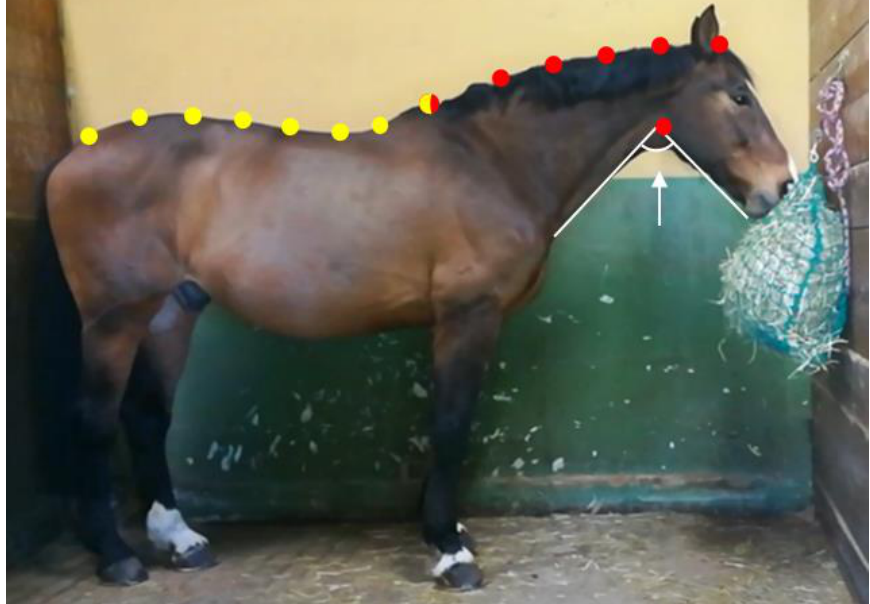
Figure 6. Geometric morphometrics analysis was applied according to the methods described by Tocco et al. [29] and Palestrini et al. [30] to evaluate the shape variations of back and neck postures. Eight configuration points were used for the back (yellow dots) and seven for the neck (red dots). The back and neck were analyzed separately to avoid the Pinocchio effect. The white arrow indicates the angle between the mandible and the underside of the neck that was calculated for each feeding position.